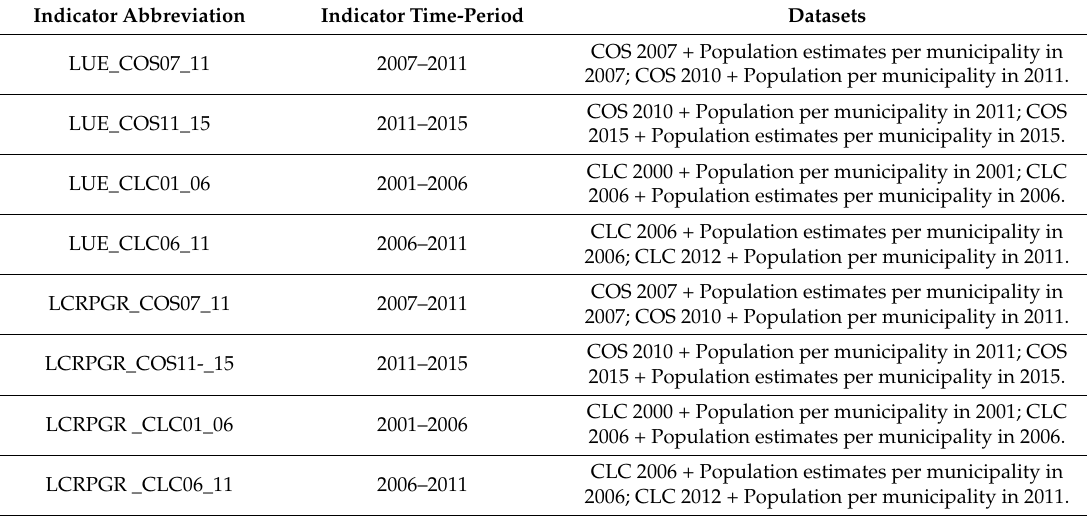
Table 1. Main datasets used to produce LCRPGR and LUE